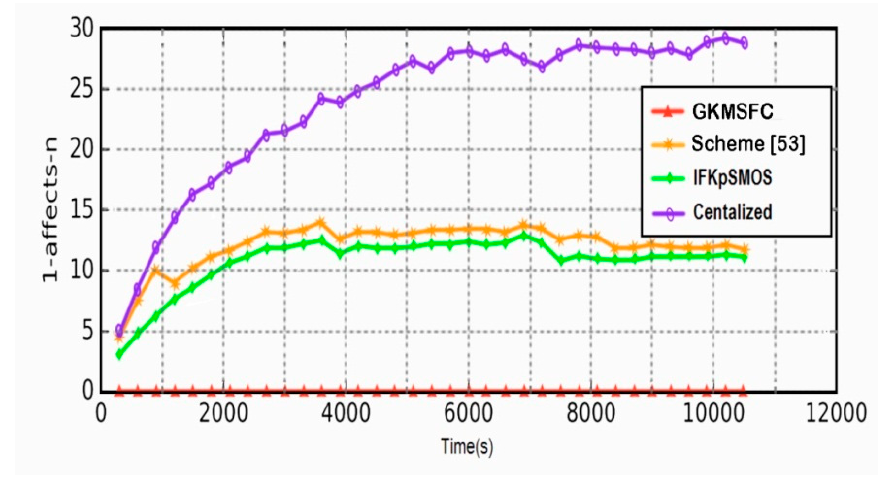
Figure 2. Compare 1-affect-n phenomenon.